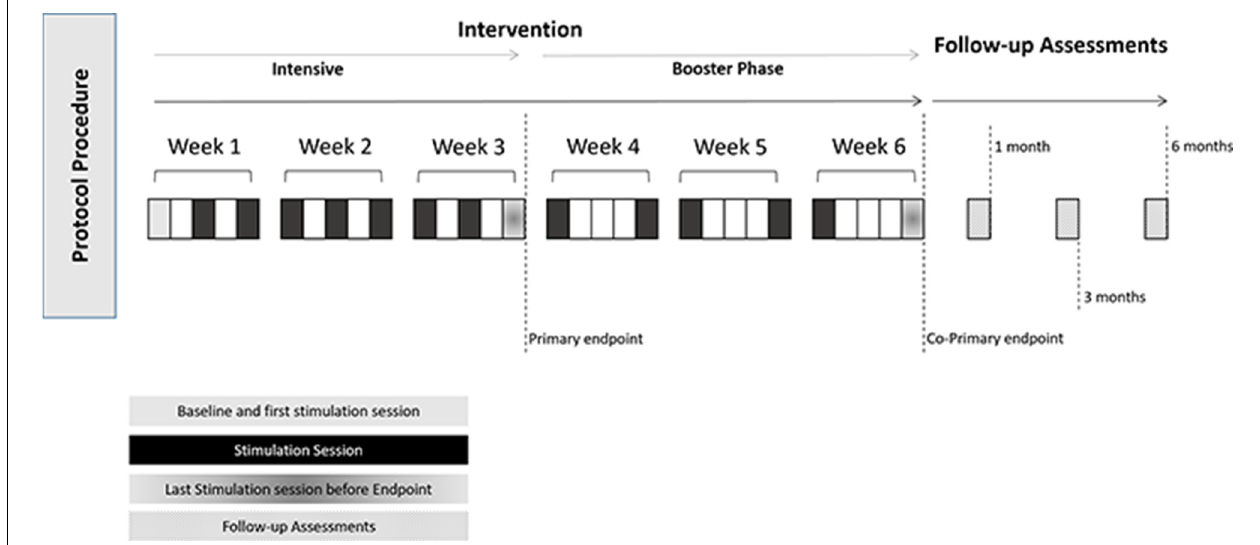
FIGURE 3 | Schematic representation of the overall procedure, including session procedure. Follow-up assessments will start 1 month after the intervention has